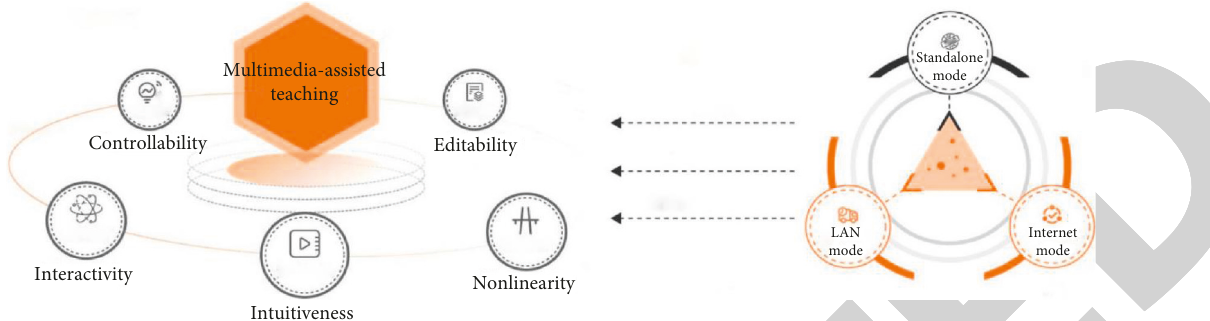
Figure 1: Characteristics and modes of multimedia-assisted teaching.